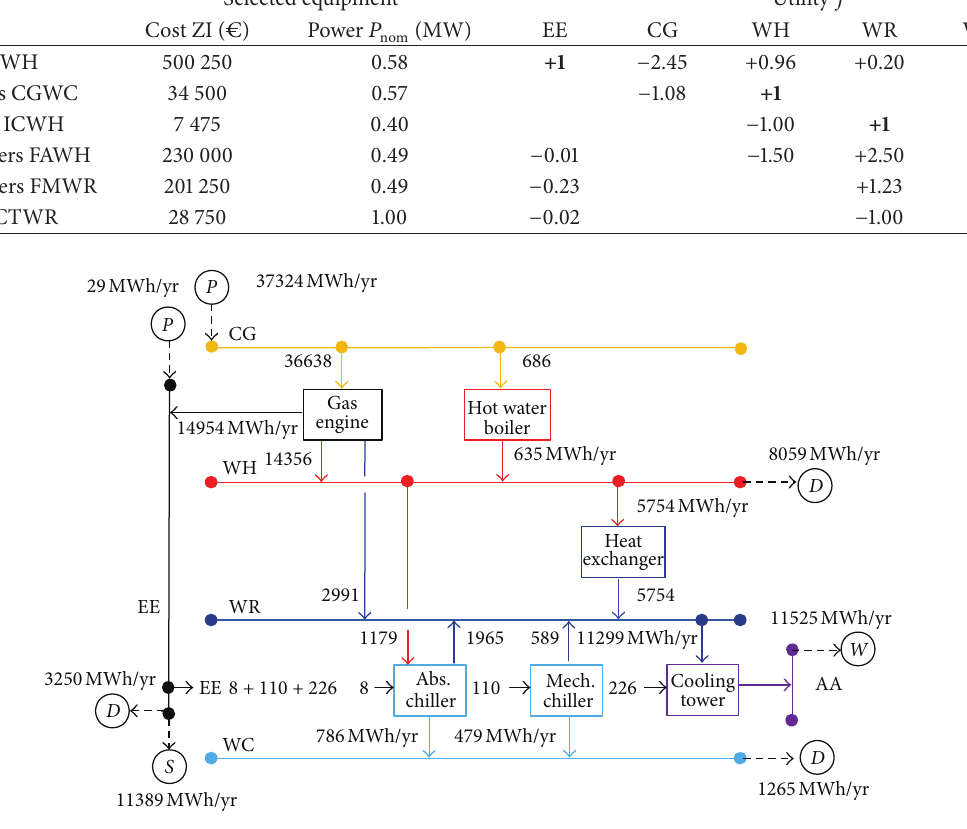
Figure 2: Structure and annual operation of the optimal trigeneration